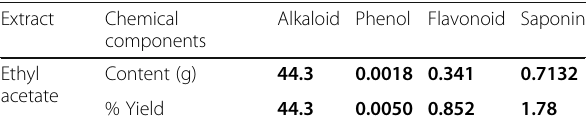
Table 4 Yield of different components present in the ethyl acetate extract of C. epigaeus